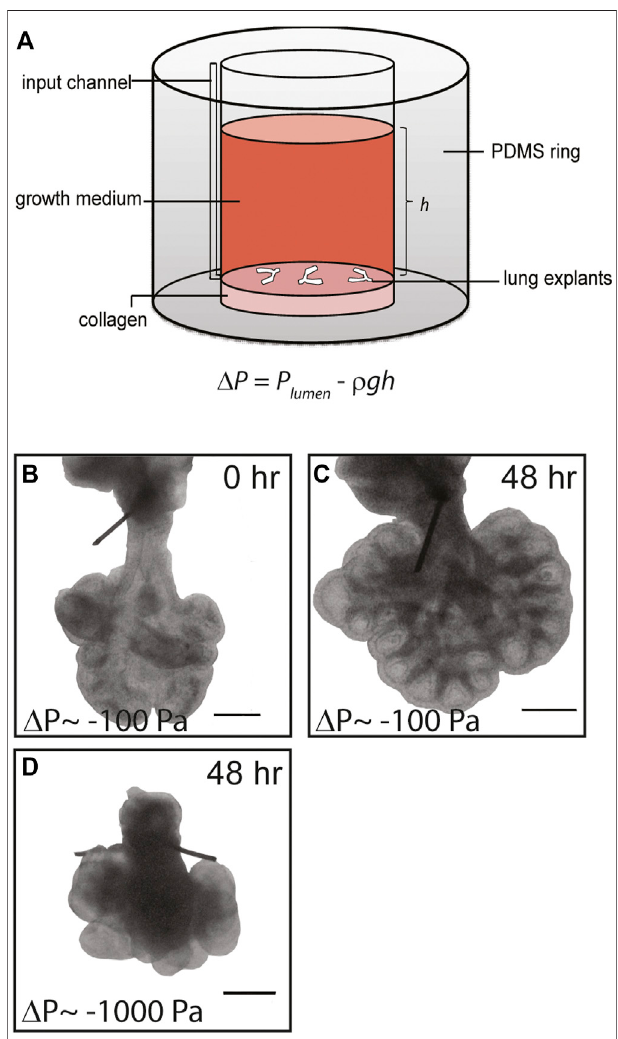
FIGURE 1 | Simple culture system to apply negative transpulmonary pressure to embryonic lung explants ex vivo. (A) Schematic of culture model. Transpulmonarypressure, Δ P ,isgivenasthedifferencebetweenthepressure within the lumen of the explant, P lumen , and the hydrostatic pressure above the explant P reservoir , which is equal to ρ gh . (B , C) Representative bright fi eldimagesof E 12.5lungexplants (B) atthestartofcultureand (C) after 48 hat Δ P (cid:1) − 100 Pa. (D) Bright fi eldimageoflungexplantculturedfor48 hat Δ P (cid:1) − 1,000 Pa. Scale bars, 250 µm.